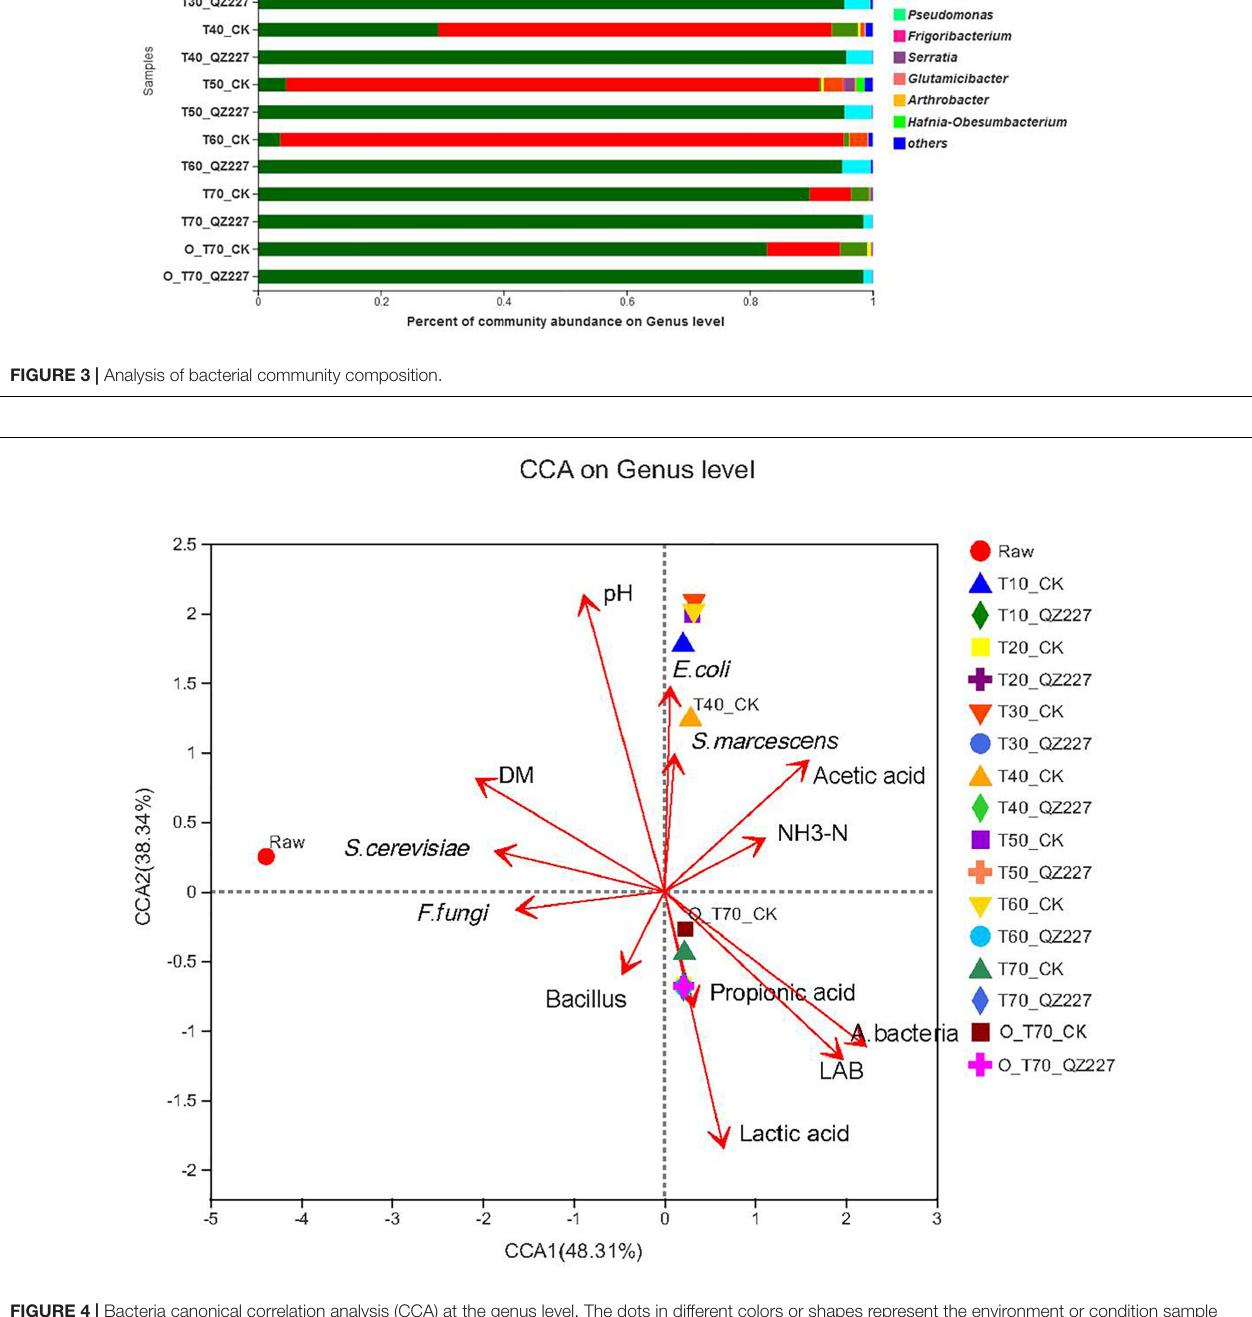
FIGURE 4 | Bacteria canonical correlation analysis (CCA) at the genus level. The dots in different colors or shapes represent the environment or condition sample groups. The red arrows represent quantitative environmental factors, and the length of the arrows for environmental factors can represent the degree of influence (explanatory volume) that an environmental factor has on the species data. The distance from the projection point of the samples to the origin represents the relative influence of the environmental factor on the distribution of the sample community.